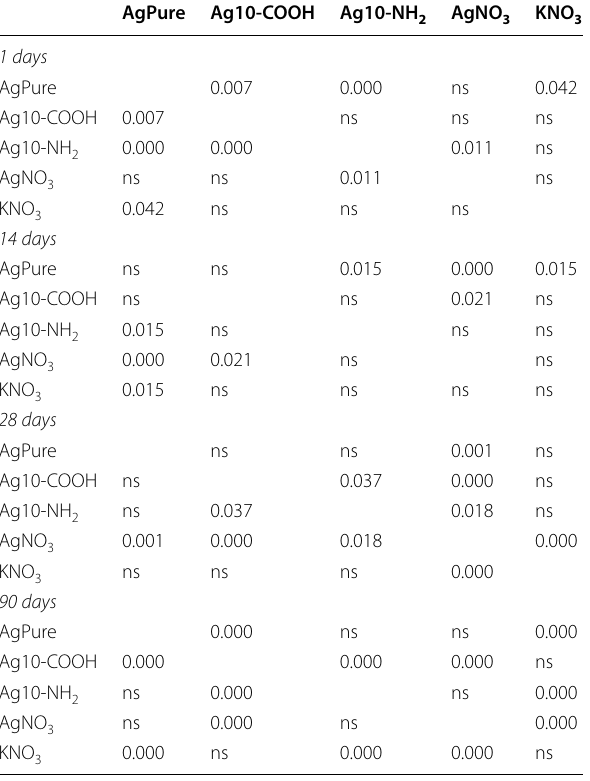
Table 4 Pairwise comparisons ( p ) of the post-hoc test, N 2400 =